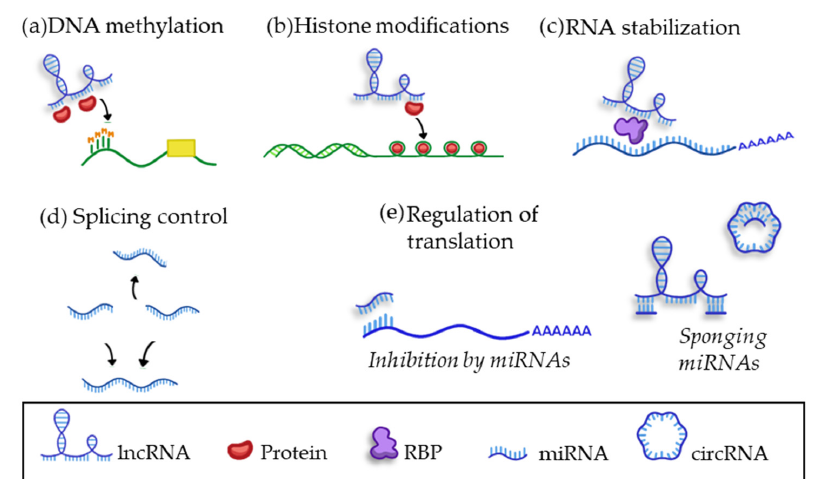
Figure 7. Main mechanisms of action of lncRNAs. ( a – c ) lncRNAs bind key proteins to promote